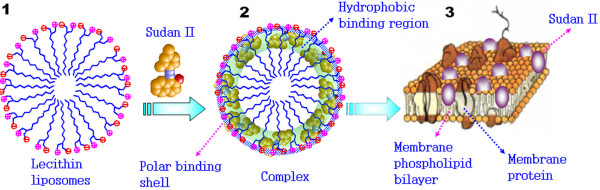
Cartoon illustrating the proposed Sudan red-liposome binding. 1, Liposome sphere; 2, Sudan II – liposome binding pattern involving hydrogen bond and hydrophobic bond; 3, Sudan II – cell membrane binding pattern.